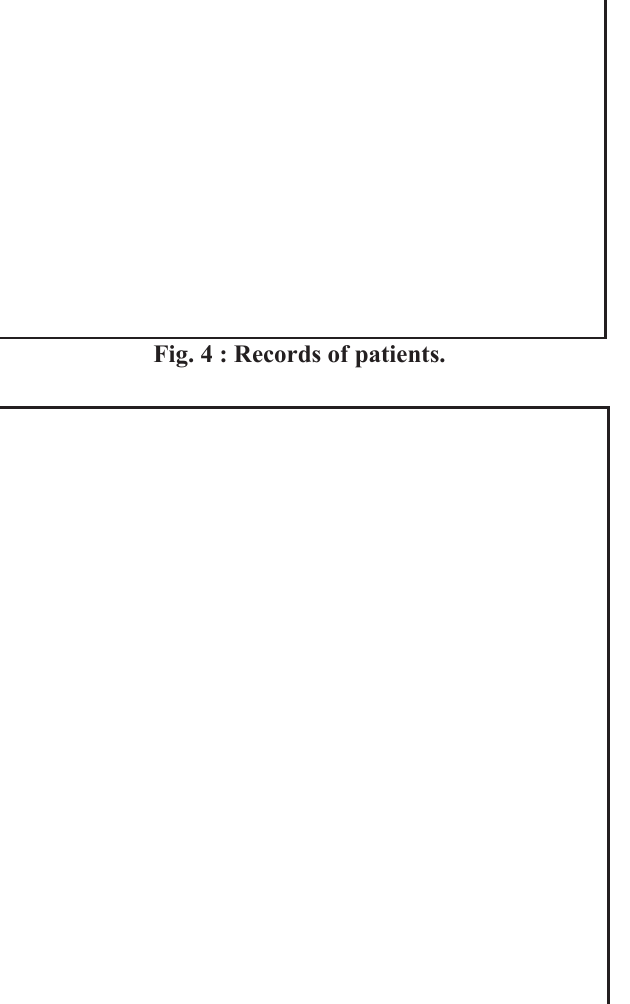
Fig. 5 : Plain sketch to be filled by interpreter after read - ing X-rays.